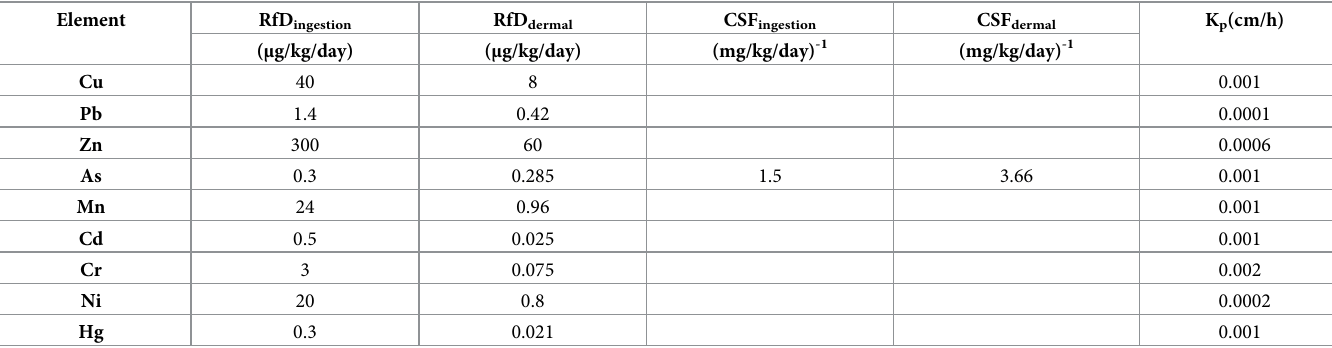
Table 3. RfD, CSF and Kp of heavy metals. Element